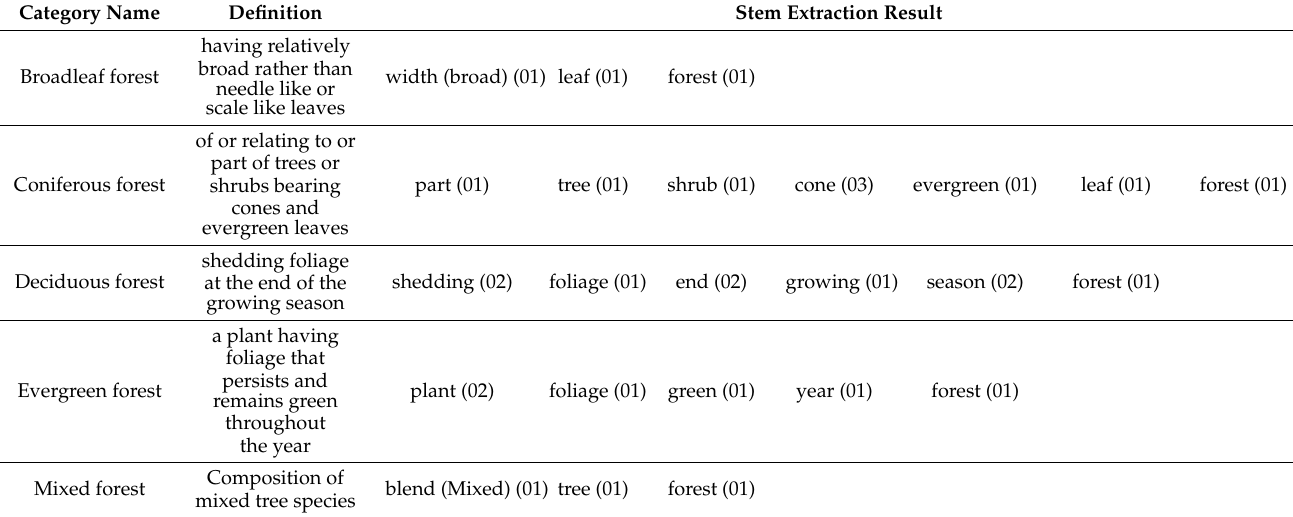
Table 3. Change detection accuracy of pixel-based Landsat satellite imagery.